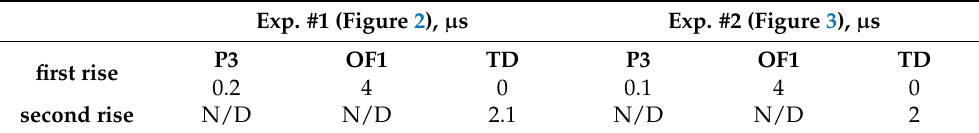
Figure 3. Exp. #2 time histories for P3 [atm], OF1 and OF2 [a.u.], TD [MW/m 2 ]. Dashed lines are tangents to baselines. Table 2. Rise moments from sensors